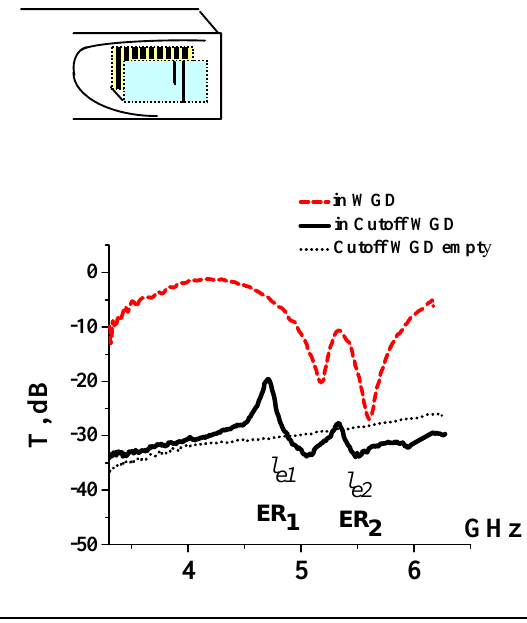
Fig. 12. Frequency dependences of transmission T in the WG and cutoff WG in t he presence of “Grating - two p arallel cu t wires” metastructure: l e1 =23mm, l e2